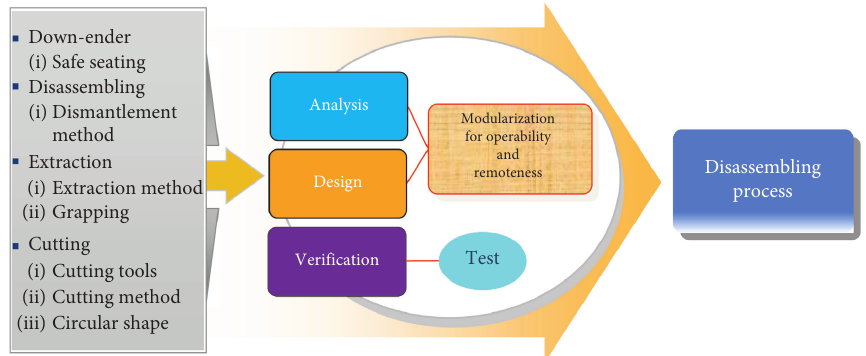
Figure 3: Design considerations for disassembling